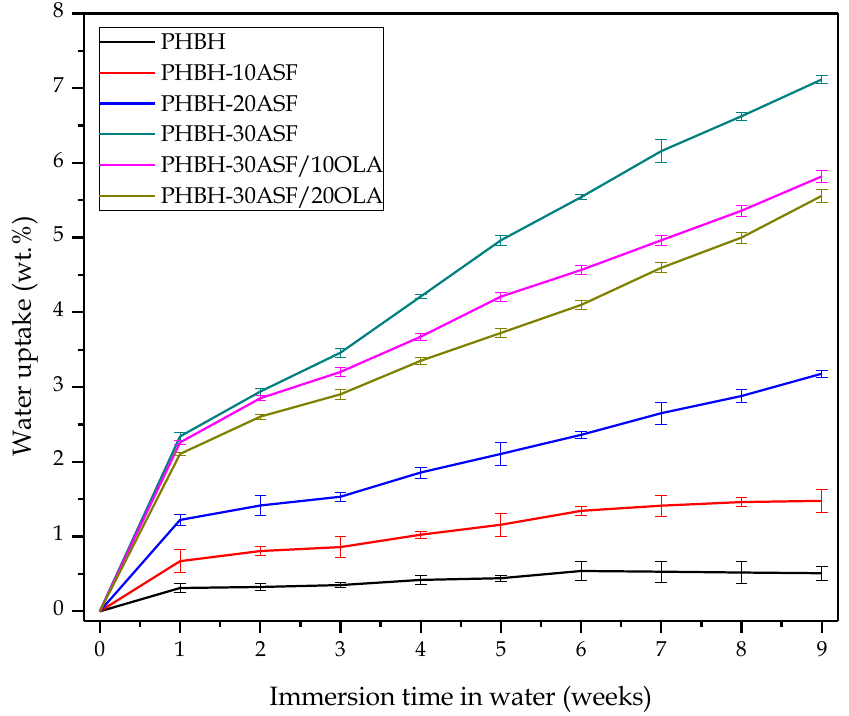
Figure 6. Water uptake of PHBH-ASF / OLA composites with di ff erent compositions. Evolution of the water uptake for a period of nine weeks.